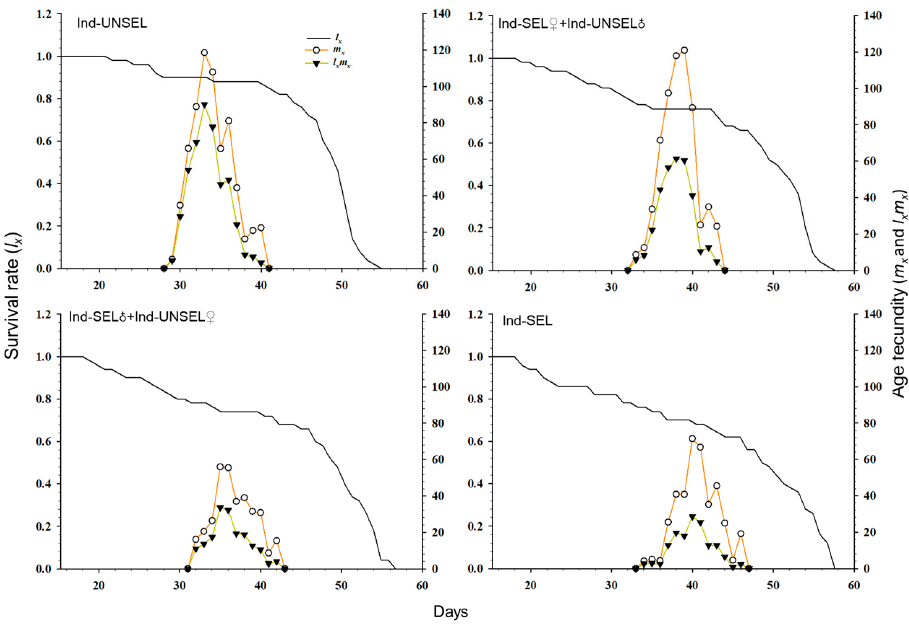
Figure 3. Age-specific survival rate ( l x ), age-specific fecundity ( m x ), and net maternity ( l x m x ) of Ind-UNSEL, Ind-SEL ♀ × Ind-UNSEL ♂ , Ind-SEL ♂ × Ind-UNSEL ♀ and Ind-SEL population of S. frugiperda.